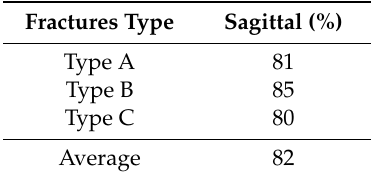
Figure 19. Segmentation result of the calcaneal fractures in the sagittal images: ( a ) Type A; ( b ) Type B; and ( c ) Type C. Table 2. Accuracy of the fractures type detection in the sagittal image.